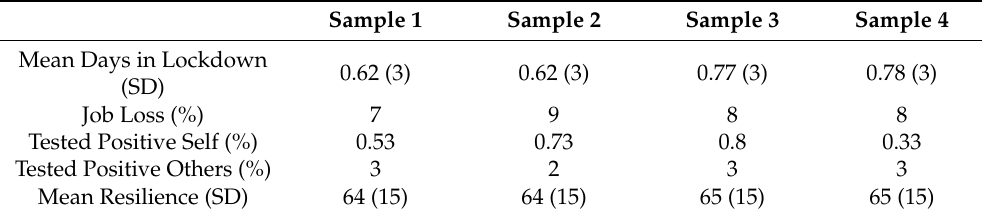
Table 3. COVID-19 impact measures and mean psychological resilience, as measured by the CD-RISC scale, ranging from 0–100 with higher values indicating greater resilience. Sample 1 Sample 2 Sample 3 Sample